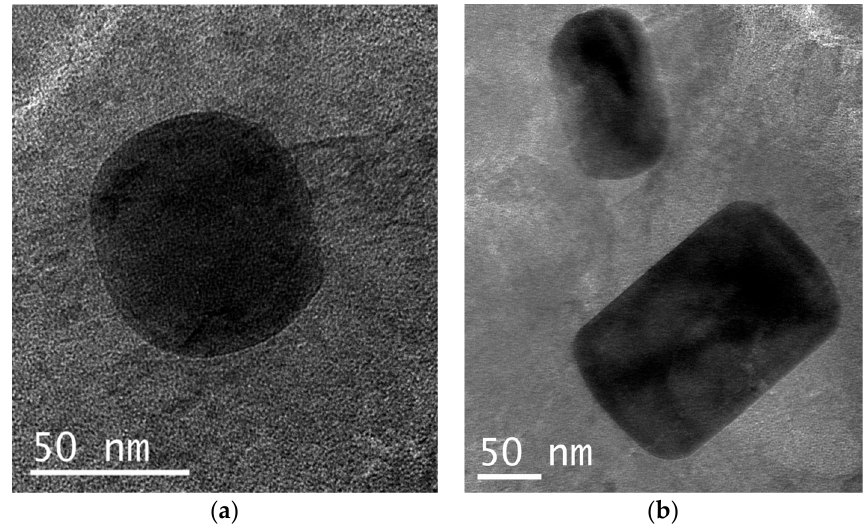
Figure 10. ( a ) Spherical Ti(Nb)N precipitate in Steel B. ( b ) 100 nm Ti(Nb)N and 50 nm Nb(Mo)C precipitates in Steel C.